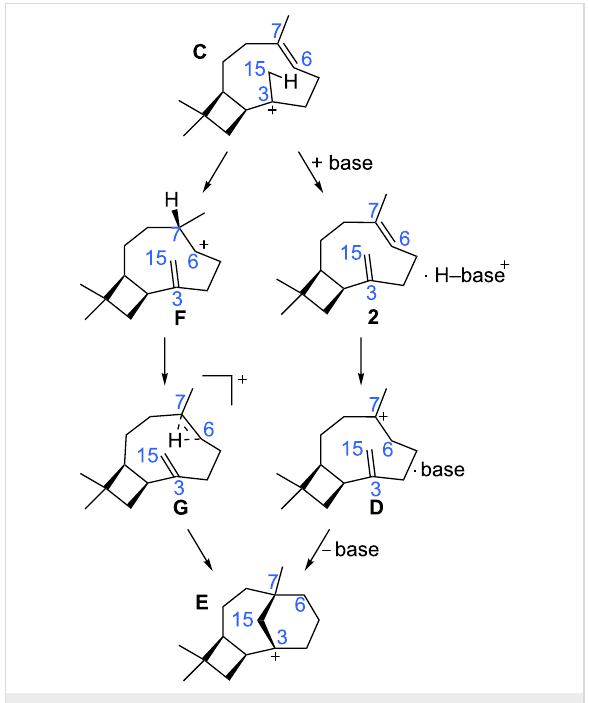
Scheme 2: Alternative mechanisms for caryolene formation.